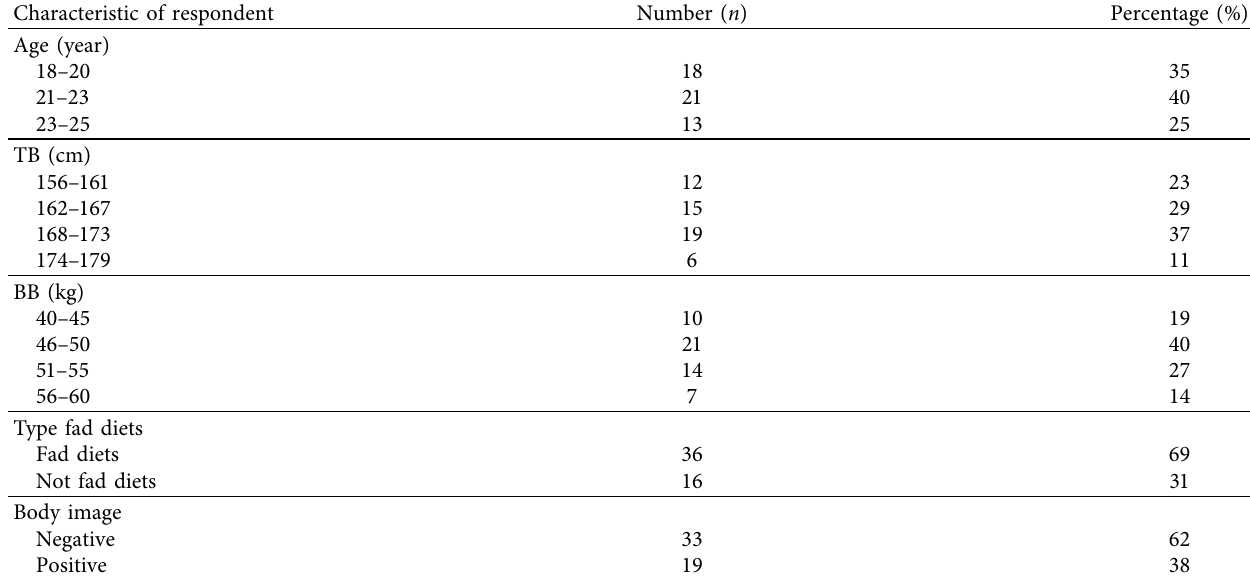
Table 1: The distribution of respondents’ characteristic, fad diets, and body image of female models in Malang City. Characteristic of respondent